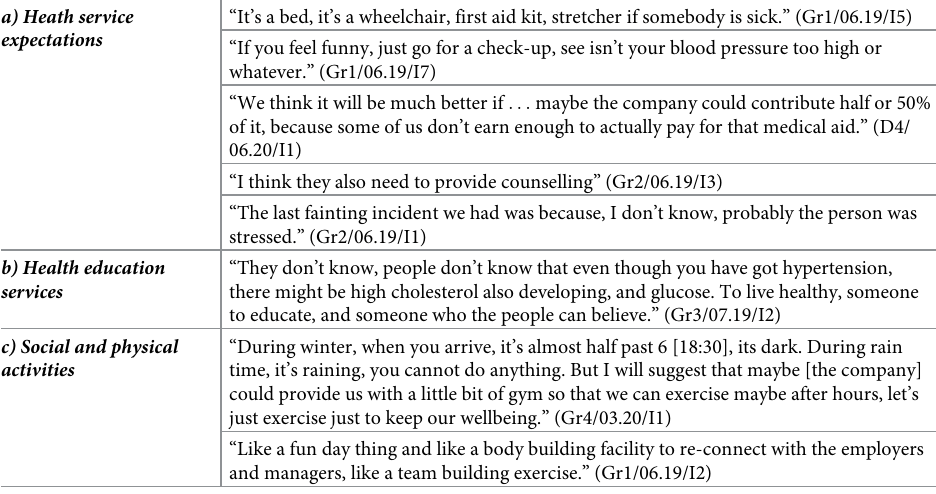
Table 4. Organisational support for employee health, sub-themes and illustrative